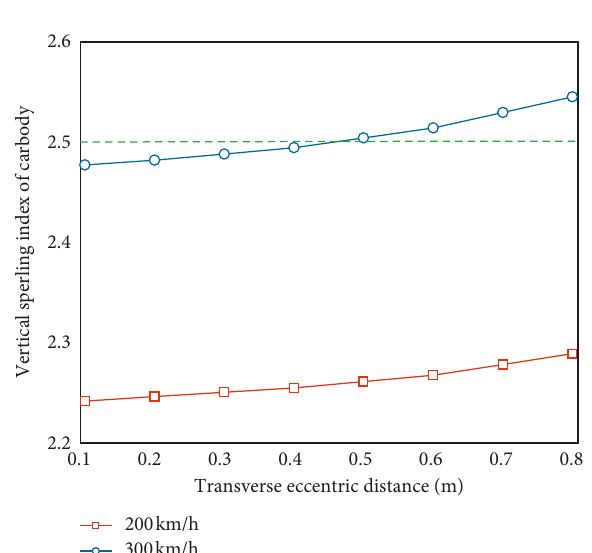
Figure 7: Influence of UCE transverse eccentricity on the vertical Sperling index.